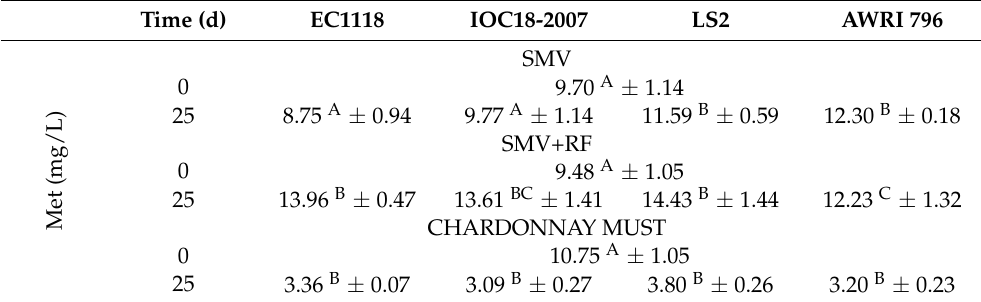
Table 3. Extracellular release of Met during the fermentation processes in the three growth media. Reported data are mean values of three replicates with the standard deviation. Different letters correspond to significant differences ( p < 0.05) among the strains grown in the same medium.